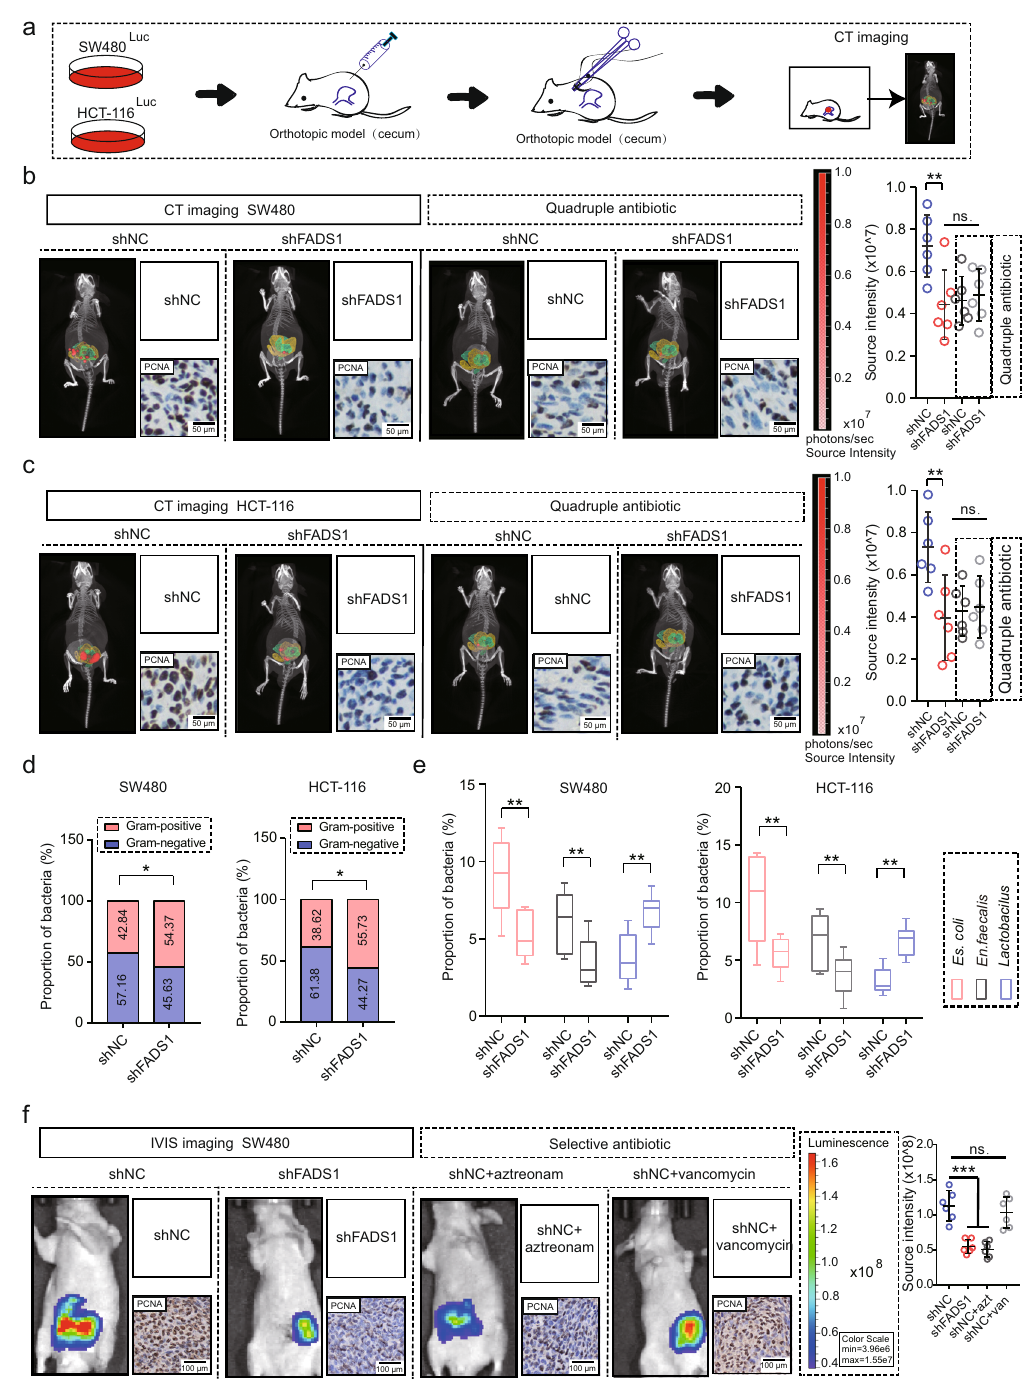
Fig. 4 | Gut microbes mediate tumor promotion of FADS1 in CRC. a An ortho- topictumormodelofCRCwasestablishedbyinjectingSW480 Luc cellsorHCT116 Luc cellsintothewallofthececumofBALB/Cnullmice. b Computedtomography(CT) with3Dorganreconstructionbioluminescenceimagingoftheorthotopictumorof BALB/C null mice injected with shNC and sh FADS1 SW480 Luc cells ( n =6 mice per group, means ± s.d.; two-tailed unpaired t test). Gut microbes were deleted by quadruple antibiotics for two weeks. The yellow signal represents intestine, the greensignalrepresentscolonandtheredsignalrepresentstumor.Scalecolourbar: 1×10 6 − 1.00×10 7 . ** p =0.007. c CT with 3D organ reconstruction bioluminescence imagingoforthotopictumorsinBALB/CnullmiceinjectedwithshNCand shFADS1 HCT116 Luc cells ( n =6 mice per group, means ± s.d.; two-tailed unpaired t test). Gut microbes were deleted by quadruple antibiotics for two weeks. The yellow signal represents intestine, the green signal represents colon and the red signal